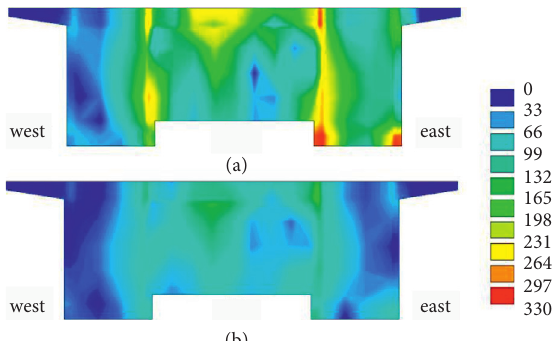
Figure 12: Stress distribution of S-type diaphragms at failure: (a) diaphragm 1.25m from bridge centerline and (b) diaphragm 6.25m from bridge centerline (unit: MPa).